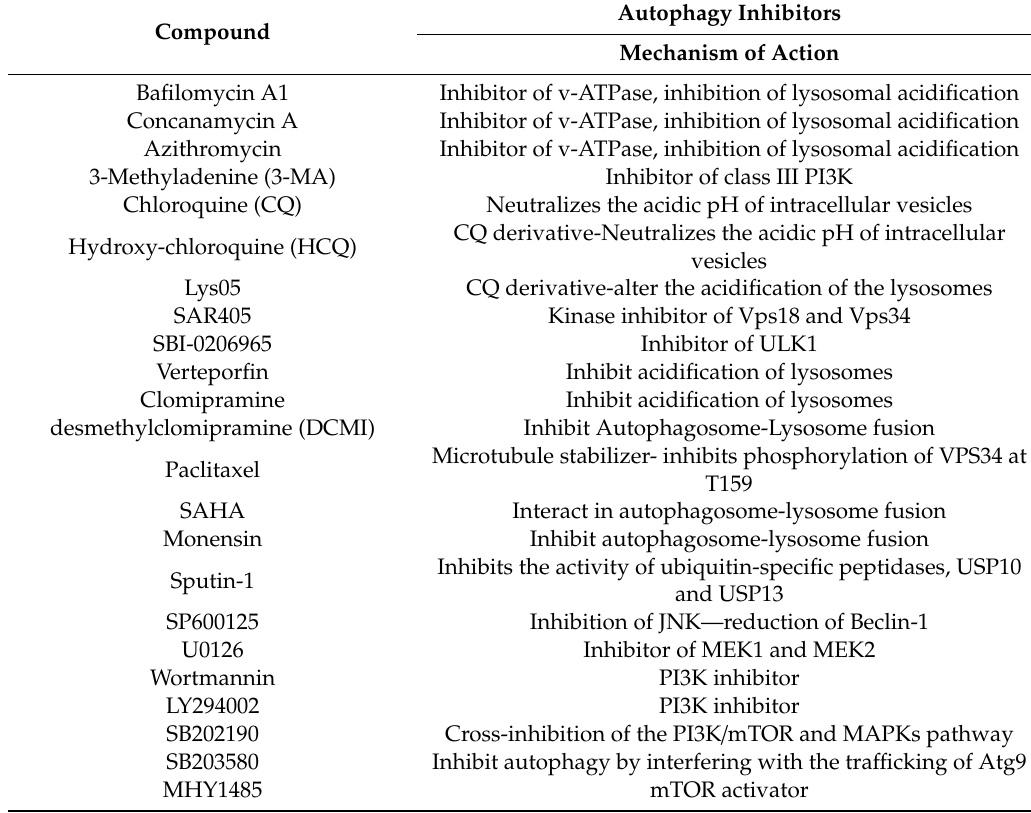
Table 2. Commonly used molecules inhibiting autophagy. Small molecules that have been identified as inhibitors of autophagy and the main mechanism of action.